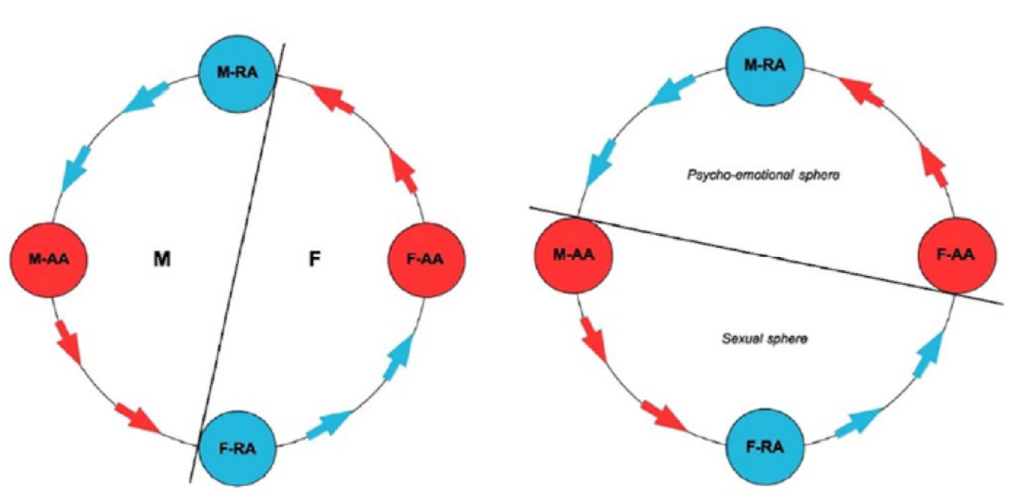
Figure 1. Representation of the tie-up cycle. Male vs. Female hemicycles, psycho-emotional vs. sexual spheres. M-AA = Male Active Area; M-RA = Male Receptive Area; F-AA = Female Active Area; F-RA = Female Receptive Area. Red arrows are direct rewards, blue arrows are indirect rewards.